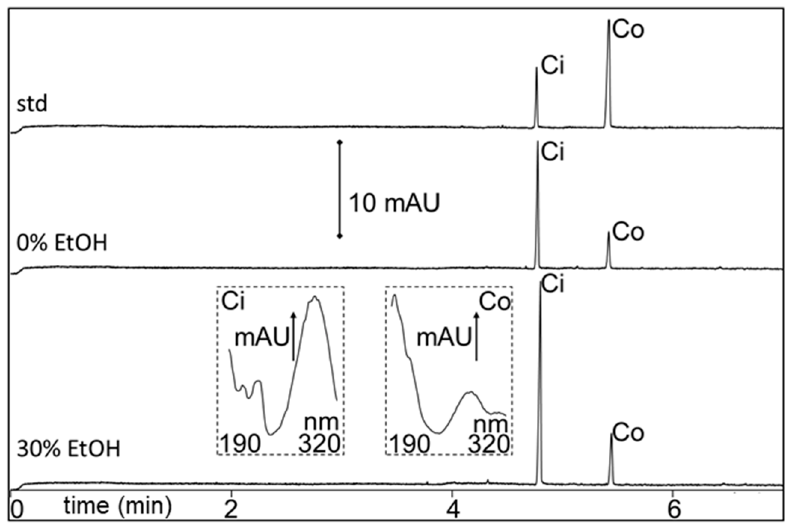
Figure 4. Representative MEKC electrochromatograms of (50 µg/mL each) cinnamaldehyde and coumarin standard mixture (std) and the first 0 and 30% EtOH extracts of Cinnamomum cassia bark sample after PHWE. Peak identity: cinnamaldehyde (Ci) and coumarin (Co). Insets show the UV spectra of the targeted metabolites. Extracts were diluted with water (1:20) before injection. Other conditions are in the Materials and Methods Section.